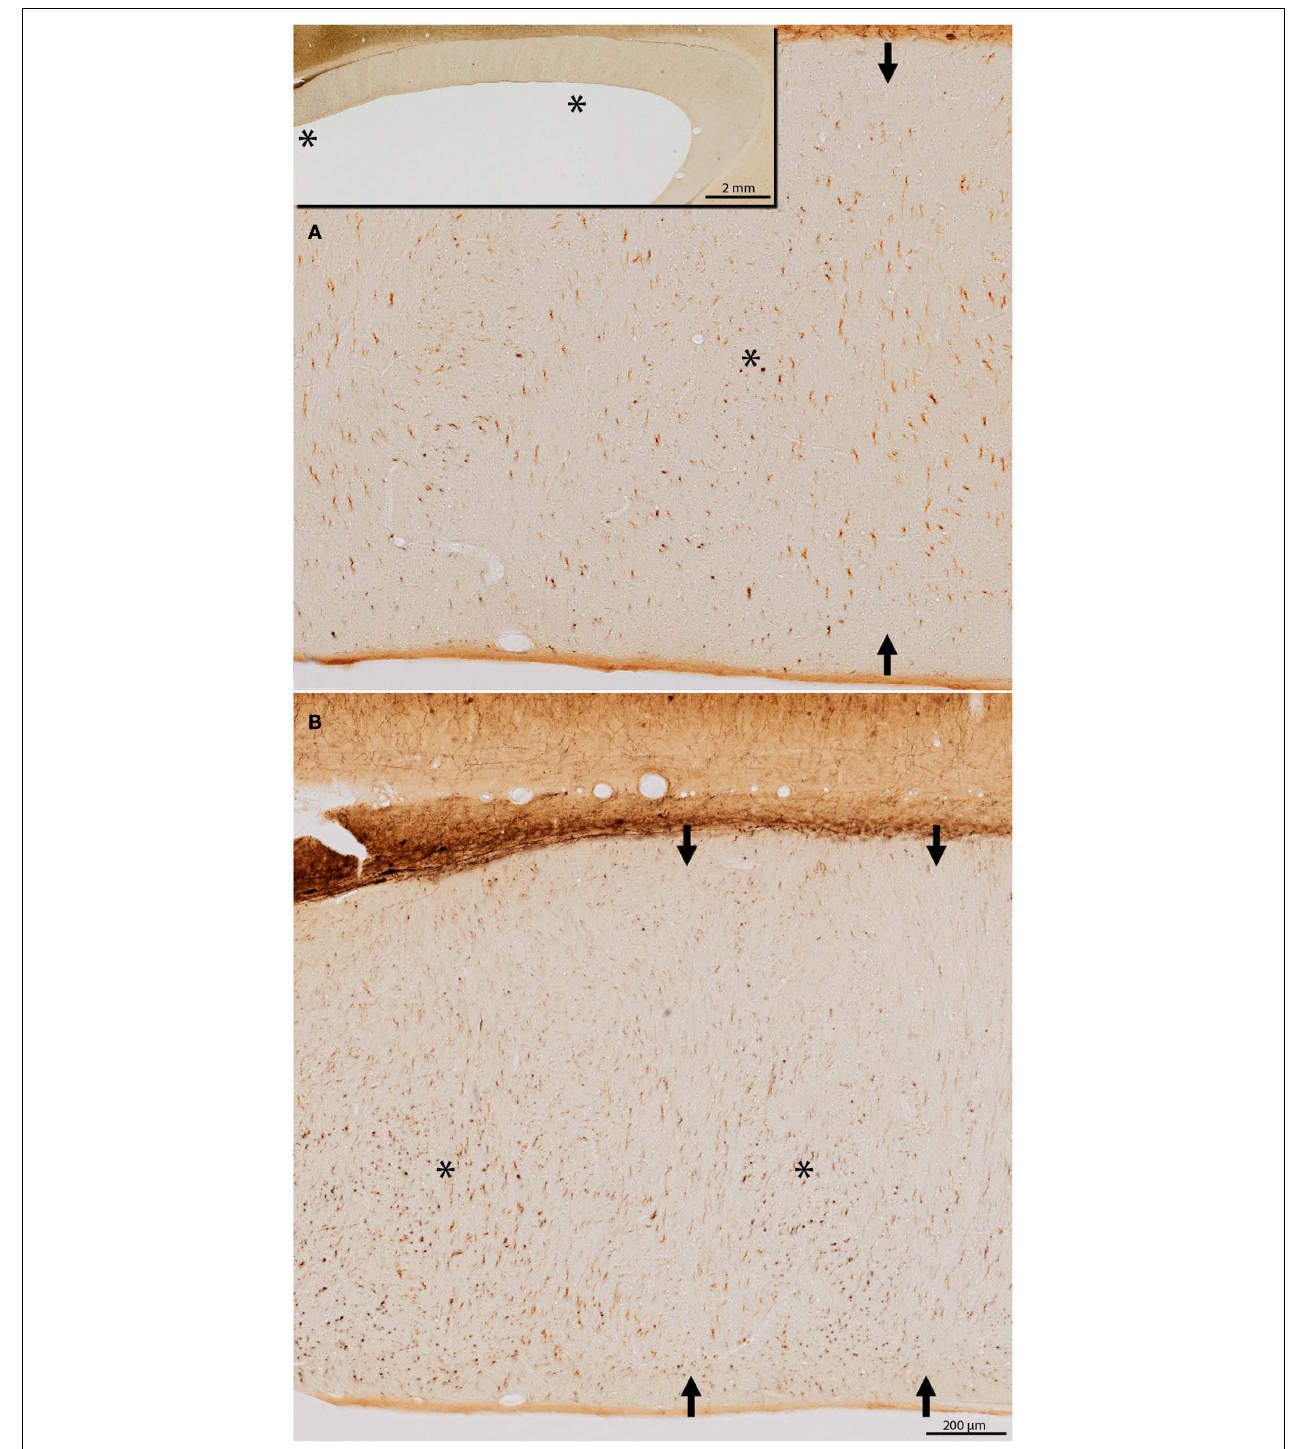
Subpopulations of PV + fibers are cut predominantly in cross section (asterisks) or oblique section (arrows), with some indication of a regular